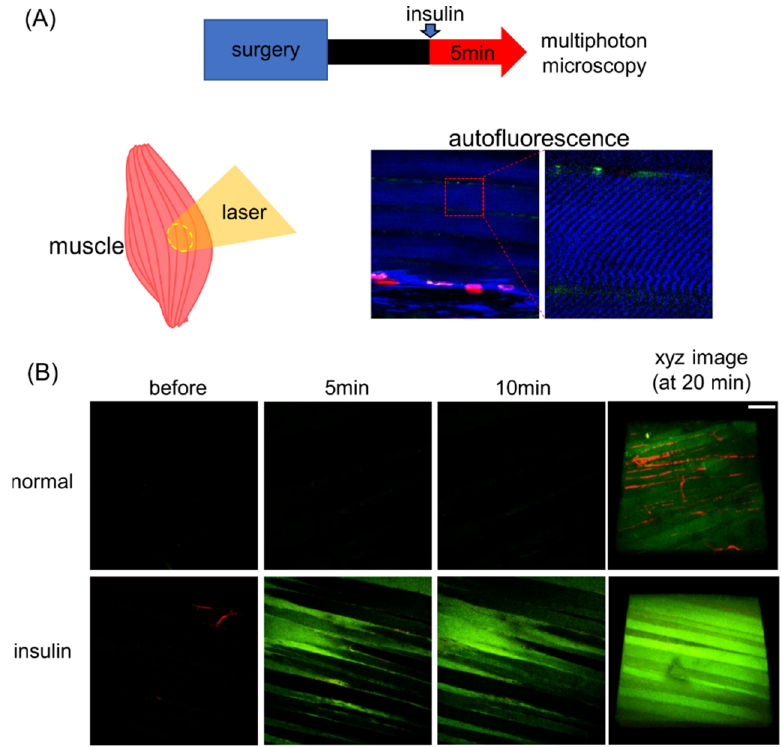
Figure 1. Intravital imaging for skeletal muscle glucose uptake. ( A ) Protocol for the skeletal muscle experiment. Insulin was injected 5 min before injection of the fluorescent glucose analog, 2-deoxy-2-[(7-nitro-2,1,3-benzoxadiazol-4-yl)amino]-D-glucose (2-NBDG). We observed skeletal muscle of the medial thigh of mice, and the focal plane was selected based on autofluorescence from muscle fibers (blue). ( B ) Representative in vivo images of 2-NBDG (green) uptake in mouse skeletal muscle before and after 2-NBDG injection ( n = 4). Scale bar = 80 µm.